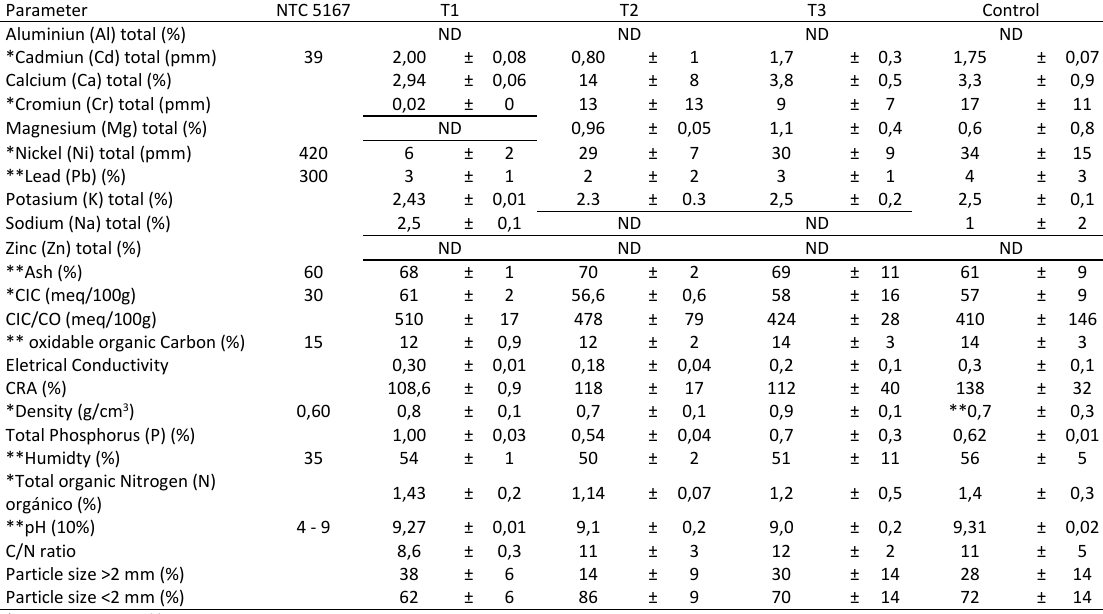
Table 2: Physicochemical parameters of the